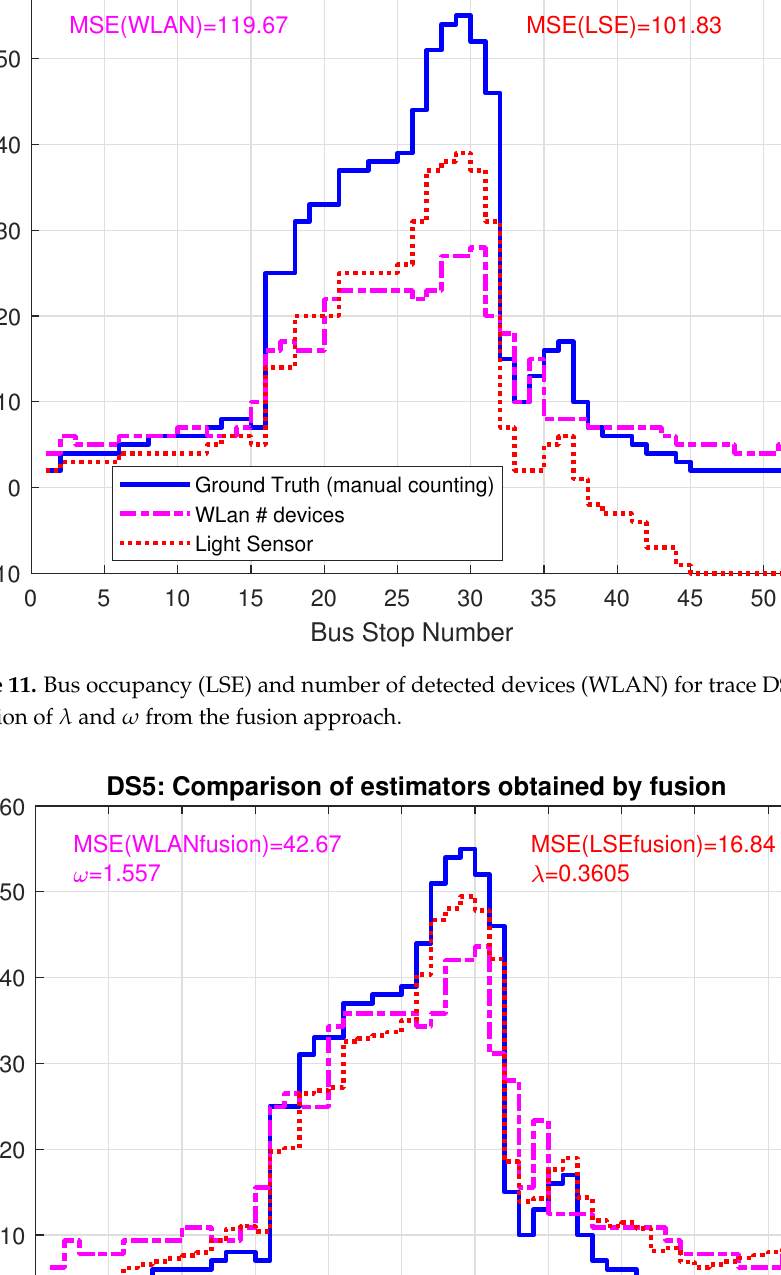
DS5: Comparison of individual occupancy/device estimators